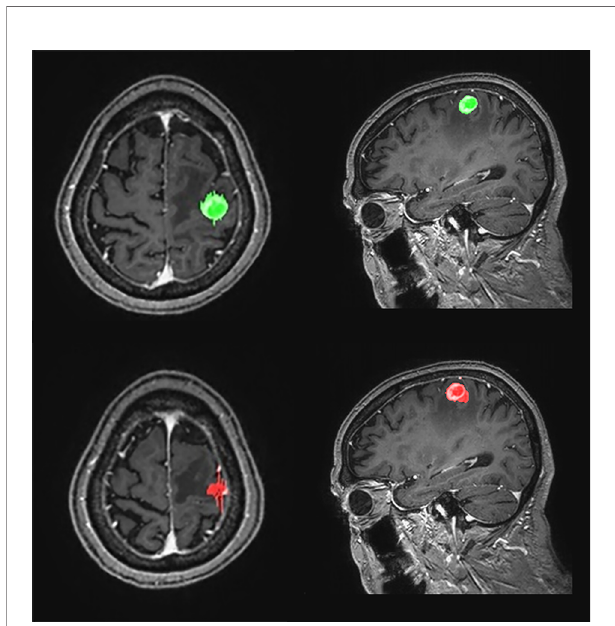
FIGURE 5 | Graphical representation of one-dimensional and volumetric measurement of the ground truth (upper row) and deep learning computer- aided detection (DL-CAD) system (lower row). The longest diameter and volume of the ground truth was 19 mm and 1597 mL, respectively, whereas the longest diameter and volume measured by DL-CAD was 27 mm and 1590 mL, respectively. Thus, volumetric measurement showed better agreement between DL-CAD and the ground truth than one-dimensional measurement (Dice similarity coef fi cient was